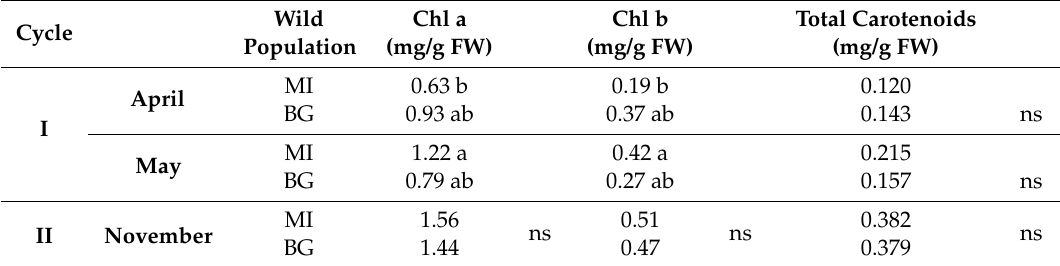
Table 2. Chlorophyll (a, b) and total carotenoid content in MI and BG hedge mustard wild populations after two production cycles. Data are reported as mg/g FW ( n = 4).